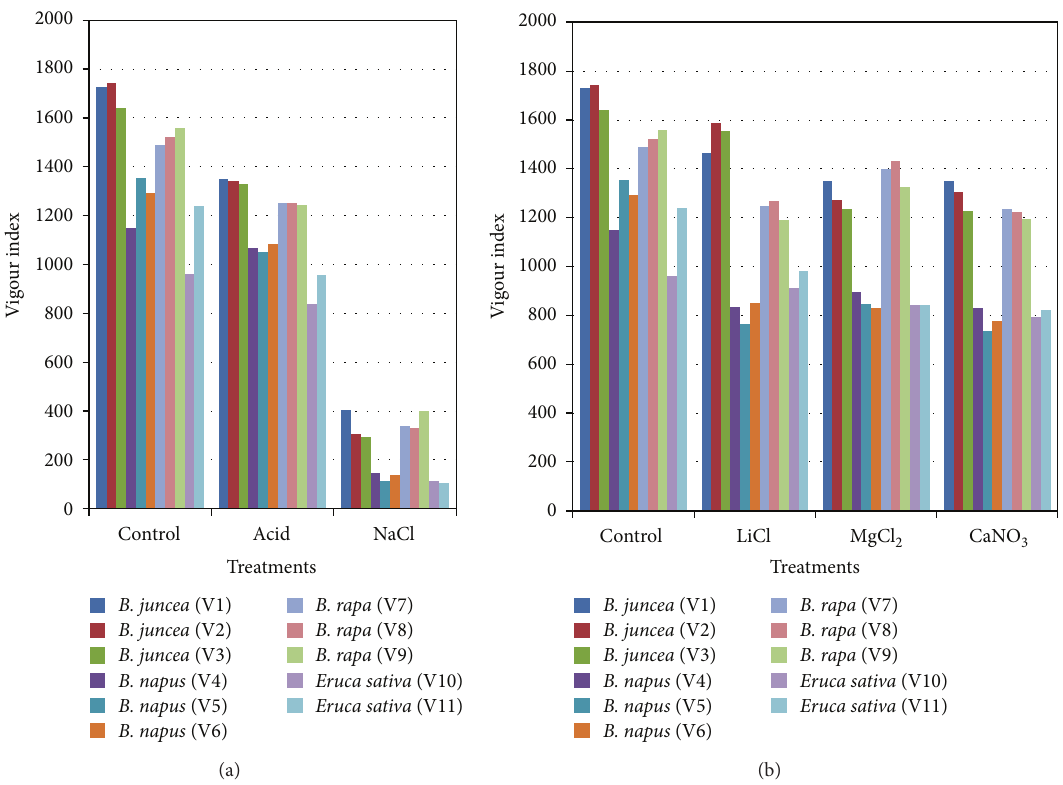
Figure 2: Effect of high and low (a) and intermediate (b) RH on vigour index of various accessions of Brassica spp. and Eruca sativa